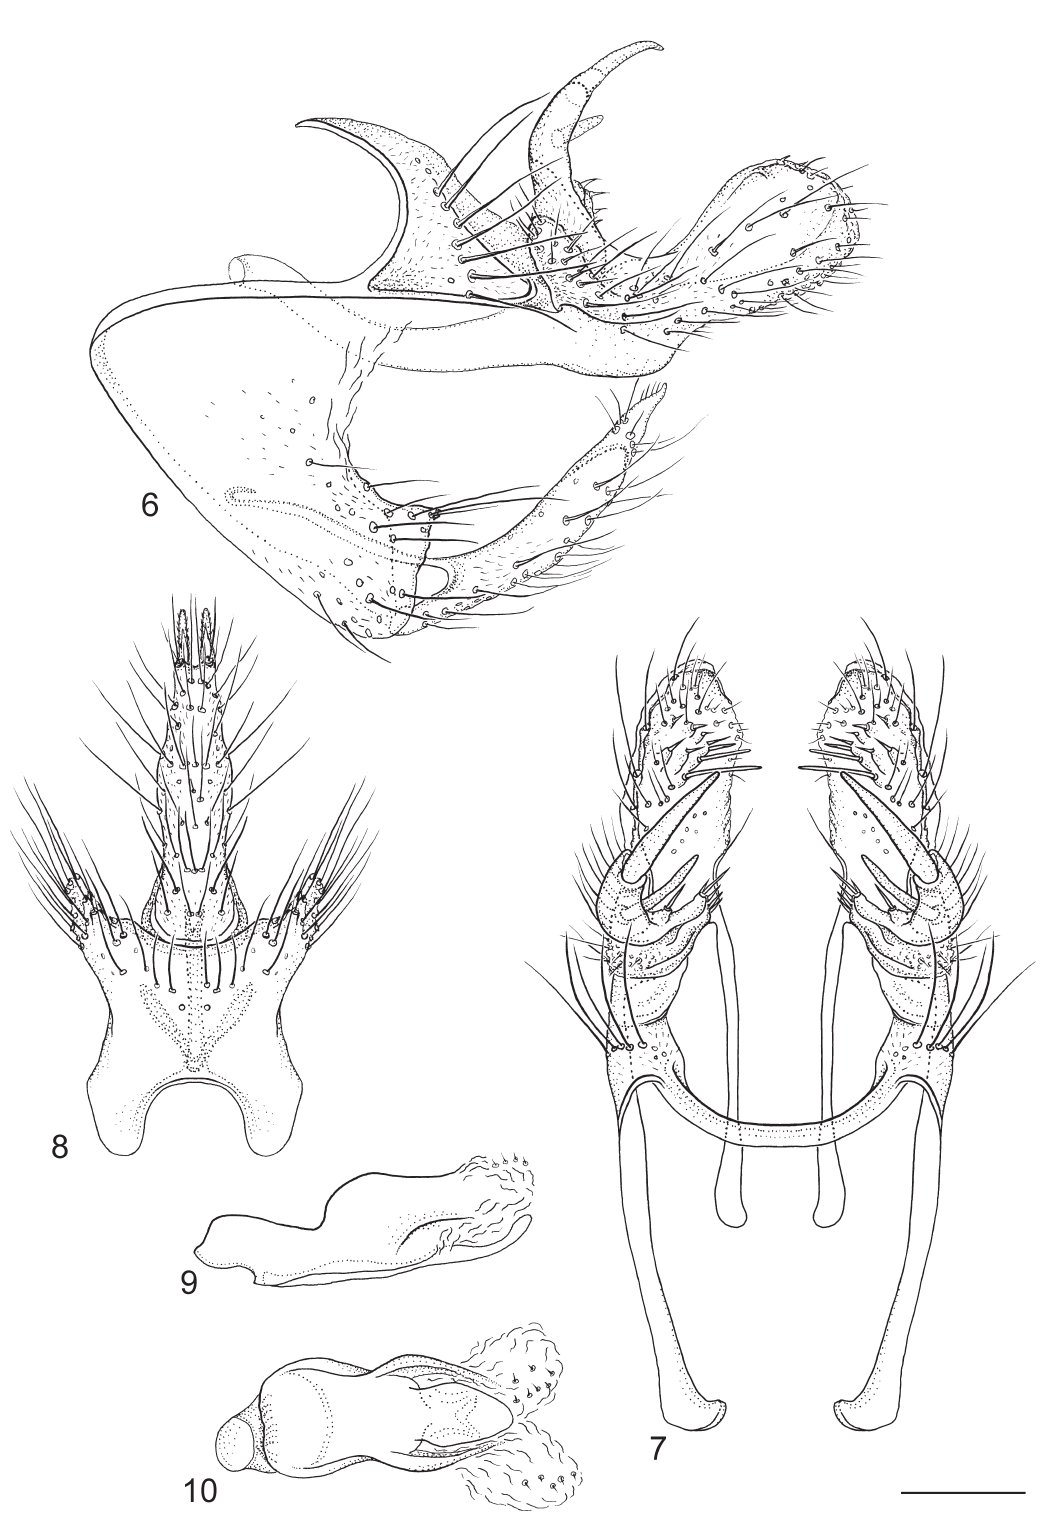
Figs 6–10. Caledomina dorsospina sp. nov., holotype, adult ♂. 6 . Genitalia, lateral view. 7 . Genitalia dorsal view. 8 . Genitalia, ventral view. 9 . Phallus, lateral view. 10 . Phallus ventral view. Scale bar = 0.1